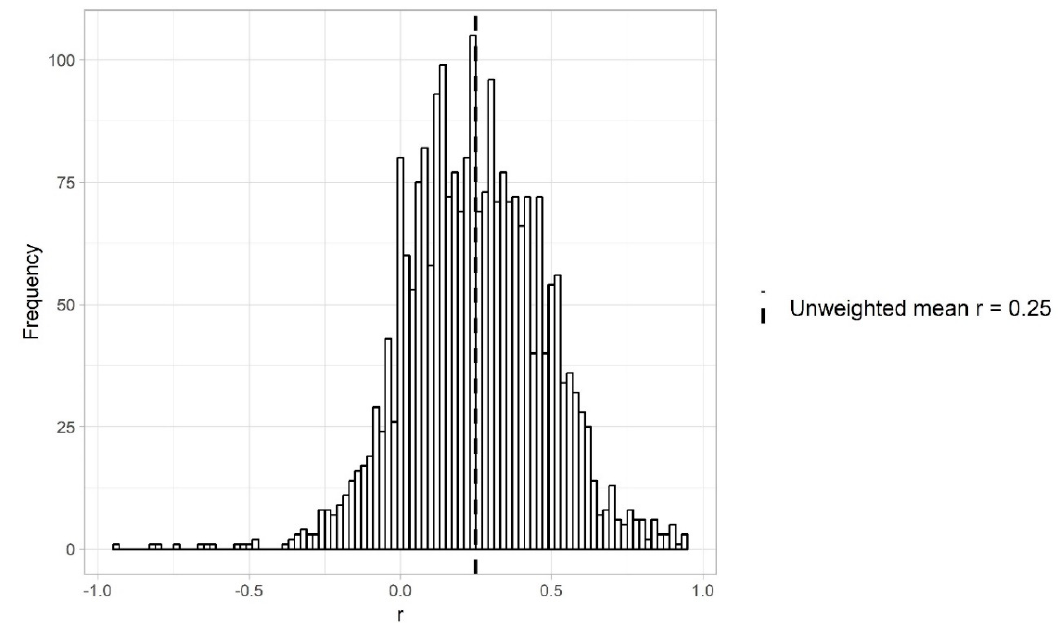
Figure 2. Histogram of the effect sizes of 2442 primary studies about intelligence. All effect sizes were converted from Fisher’s Z to Pearson’s correlation to facilitate interpretation.